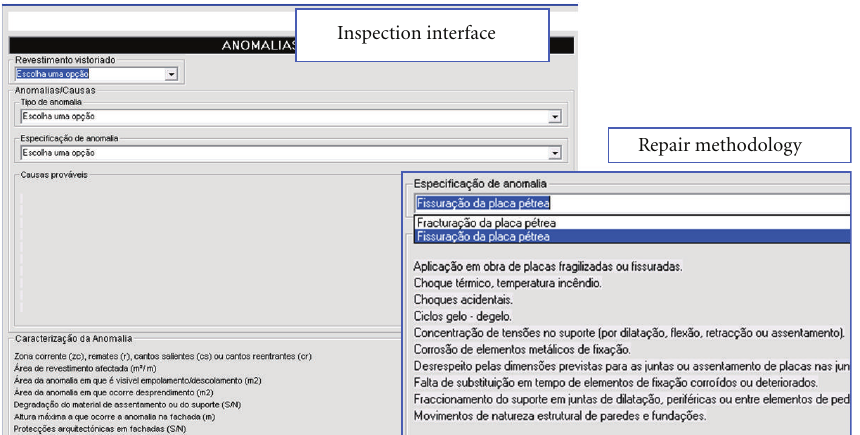
Figure 11: Inspection sheet interface.